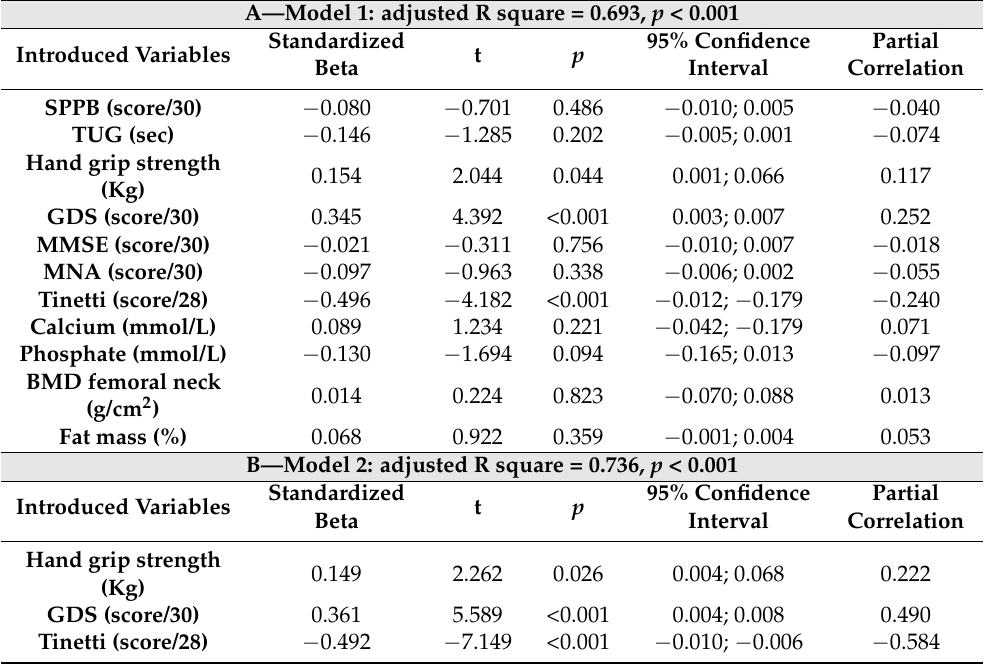
Table 6. Linear regression models predictive of frailty . The standardized beta coefficient, t, p -values, 95% CI and partial correlation are shown. (A): linear regression models taking into account variables significantly different amongst fit and frail subjects. (B): linear regression adjusted